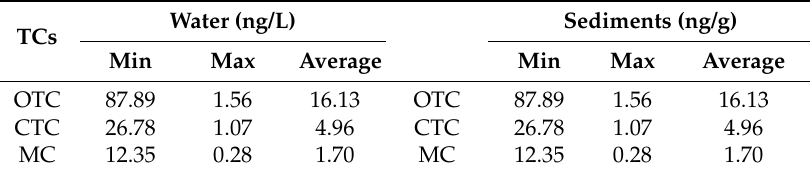
Table 1. Residue levels of tetracyclines in the Weihe